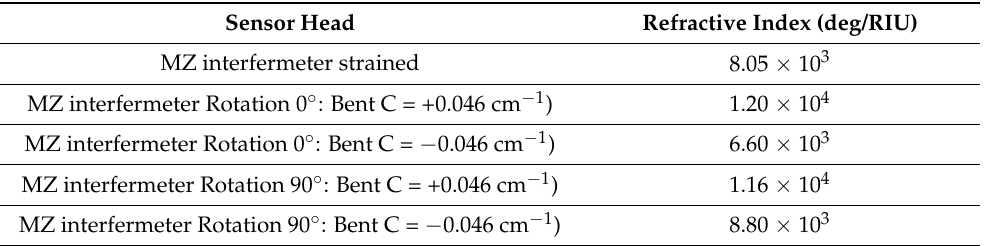
Table 3. Resume of the results obtained with the Mach–Zehnder modal interferometer for variation of the external medium refractive index when the fiber is bent in different